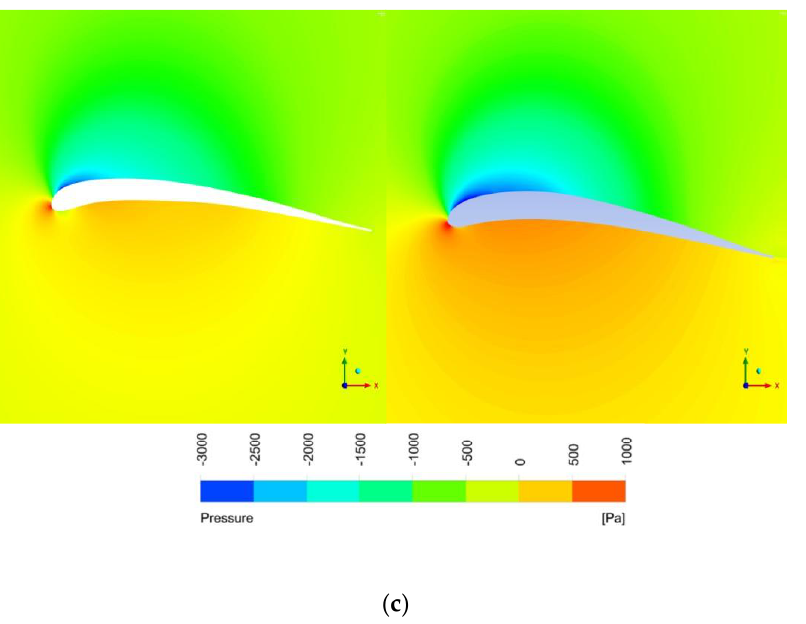
Figure 11. Three bionic airfoil pressure diagrams. ( a ) Comparison of pressure contour diagrams before and after optimization of the long − eared owl at an angle of attack of 5°; ( b ) Comparison of pressure contour diagrams before and after optimization of the seagull at an angle of attack of 4°; ( c ) Comparison of pressure contour diagrams of the sparrowhawk before and after optimization at an angle of attack of 6°. Table 4. Comparison of the initial airfoil and optimized airfoil lift coefficients at an angle of attack of 15 ◦